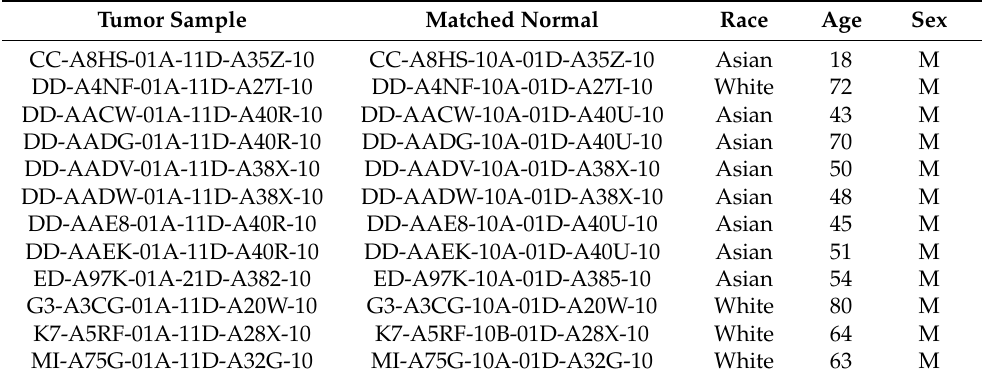
Table 1. Information on samples and patients having the guanine nucleotide-binding protein G(q) subunit alpha (GNAQ) T96S mutation in TCGA. Tumor Sample Matched Normal Race Age Sex CC-A8HS-01A-11D-A35Z-10 CC-A8HS-10A-01D-A35Z-10 Asian